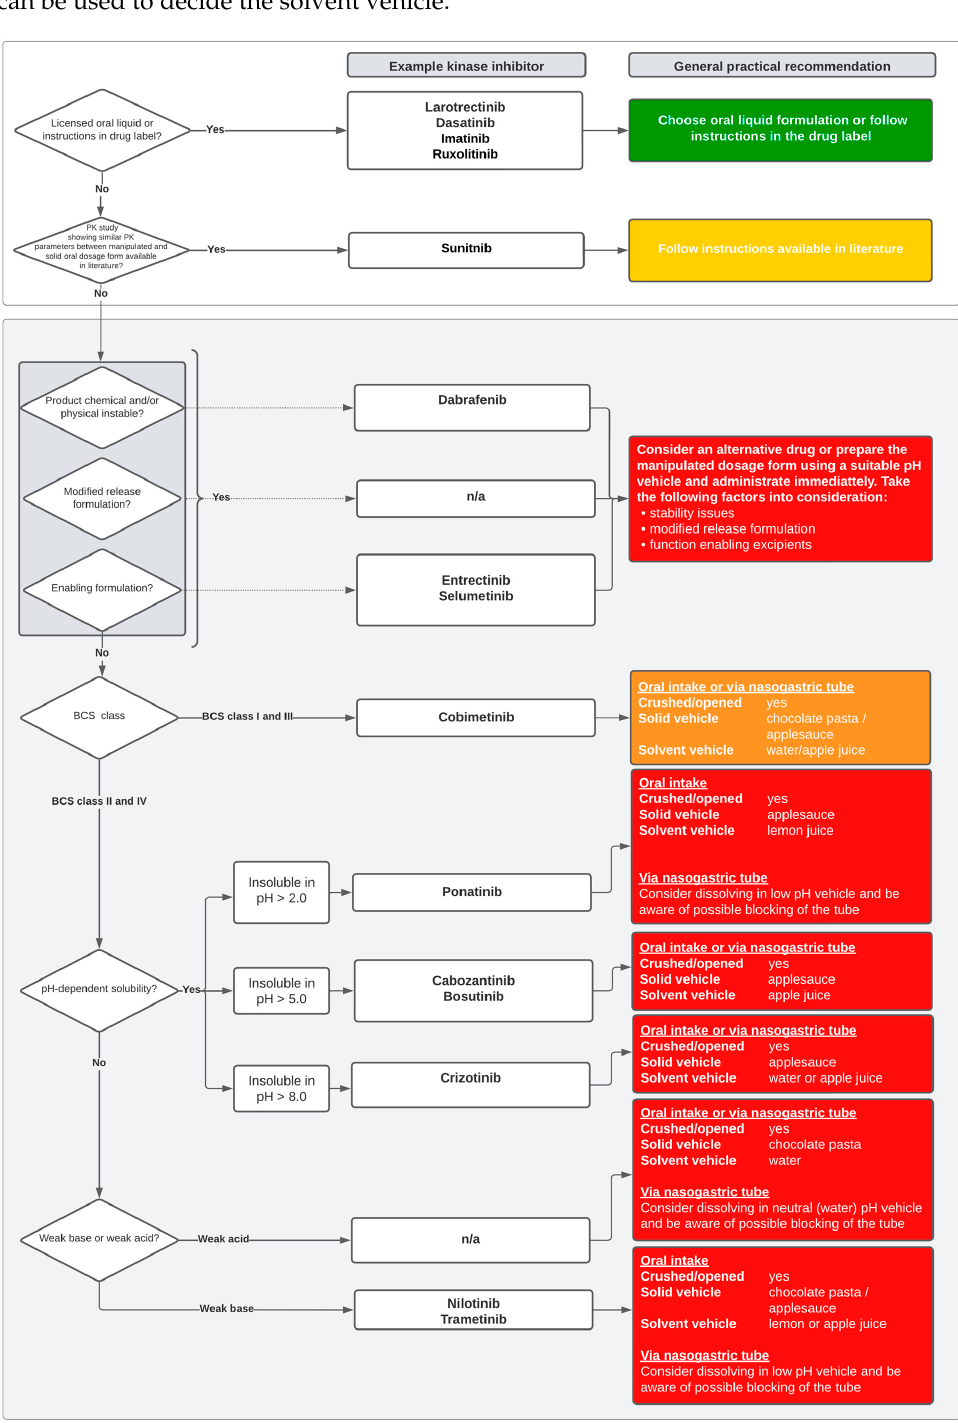
Figure 2. Decision tree for manipulating solid oral dosage forms of KIs. The colors represent the unknown risk of altering safety, stability, pharmacokinetics (AUC, Cmax) and bioavailability when ad- ministrating the manipulated dosage form (green = low risk, red = high risk); Crushed/opened = can tablet be crushed capsule be opened; Solid vehicle = possible vehicle to add to crushed tablets or content of capsules; Solvent vehicle = possible vehicle to dissolve tablets/capsule in; BCS = Bio- pharmaceutics Classification System; AUC = Area Under the Curve; Cmax = maximum plasma concentration; Tmax = time to maximum plasma